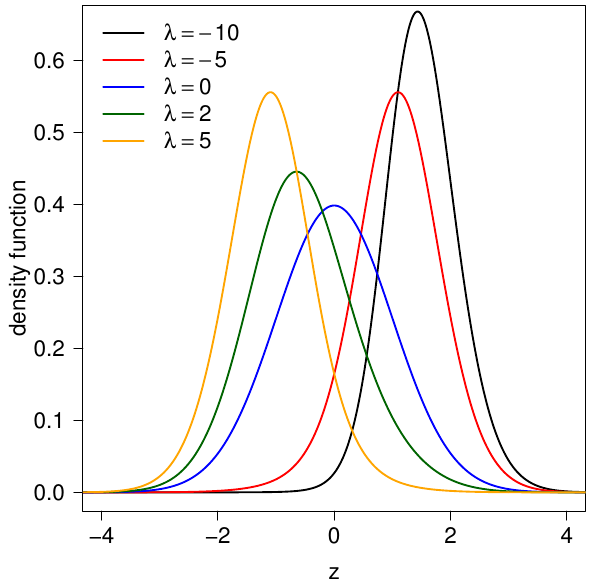
Figure 1. TESN pdf for different values of λ